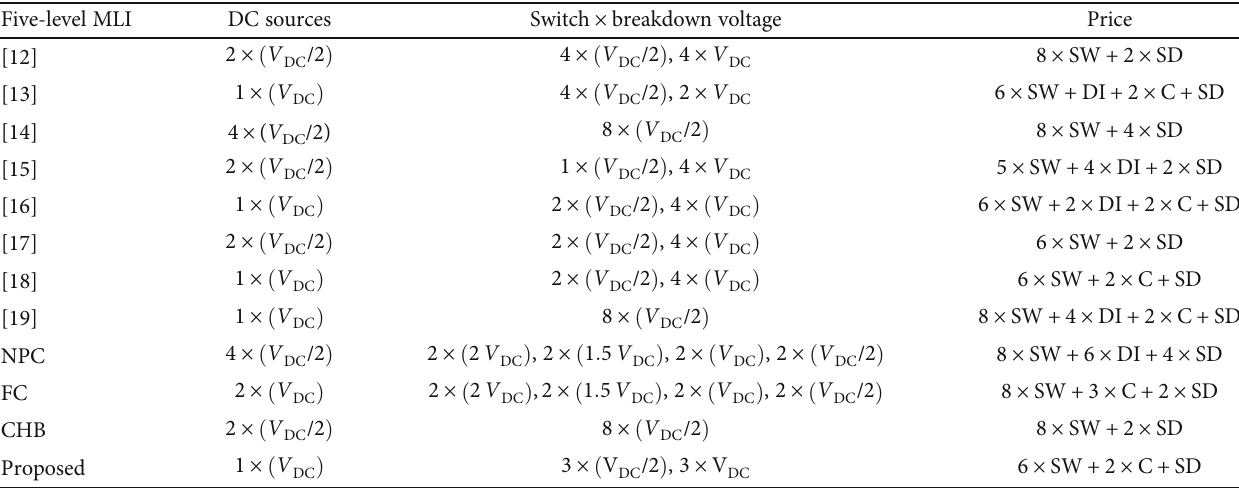
Table 3: Comparison between the proposed topology and some of the presented structures.